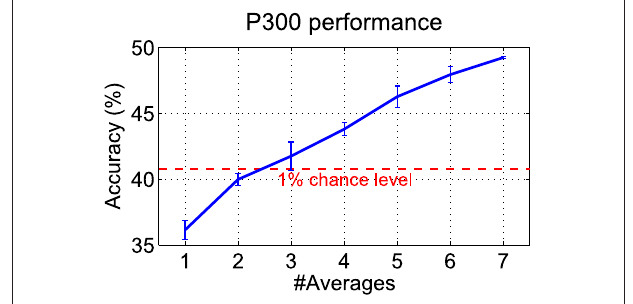
FIGURE 12 | Influence of the number of averages on the P300 performance. The grand average of the classification accuracies (10 × 10 cross-validated) over all subjects is shown when averaging different numbers of twitch segments per trial (1–7). Random subsampling was used to select different numbers of twitches within trials. The whole procedure was repeated 10 times in order to get a more reliable estimate (mean ± SD are